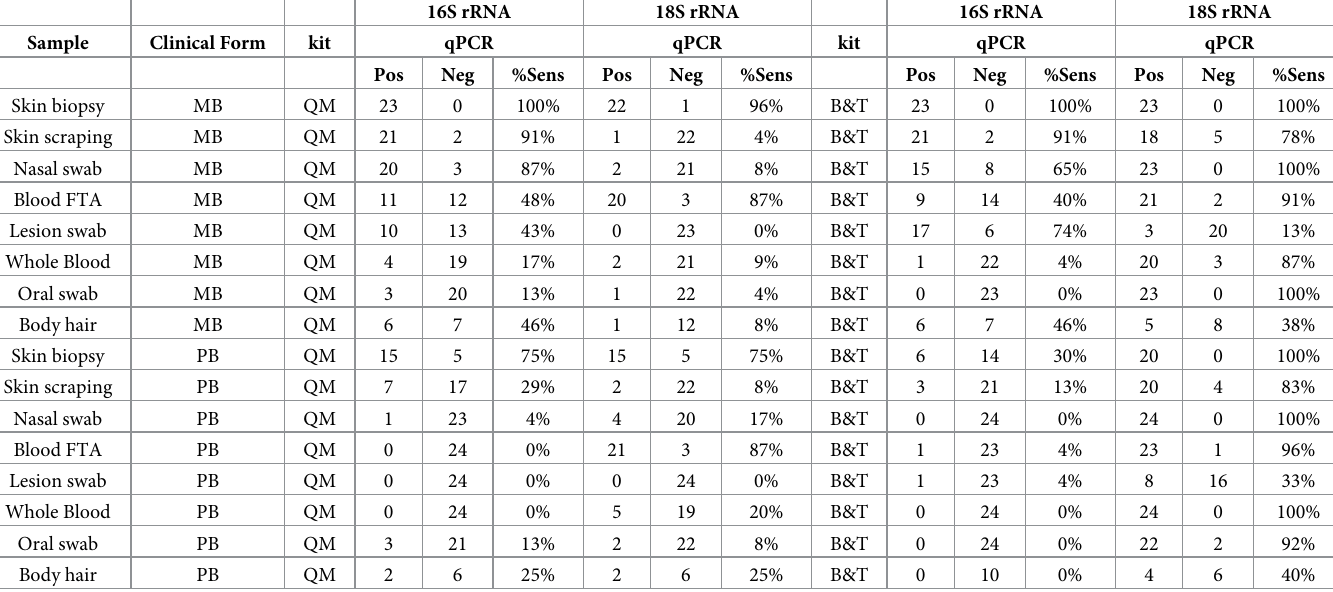
Table 1. PCR sensitivity across clinical forms, kits and targets. qPCR sensitivity (%) for the different tested targets, M leprae 16S rRNA and mammalian 18S rRNA, for each of the different biological samples obtained by the two different DNA extraction methods (DNeasy Blood & Tissue Kit and QIAamp DNA Microbiome Kit). Legend: QM: QIAamp DNA Microbiome Kit; B&T: DNeasy Blood & Tissue